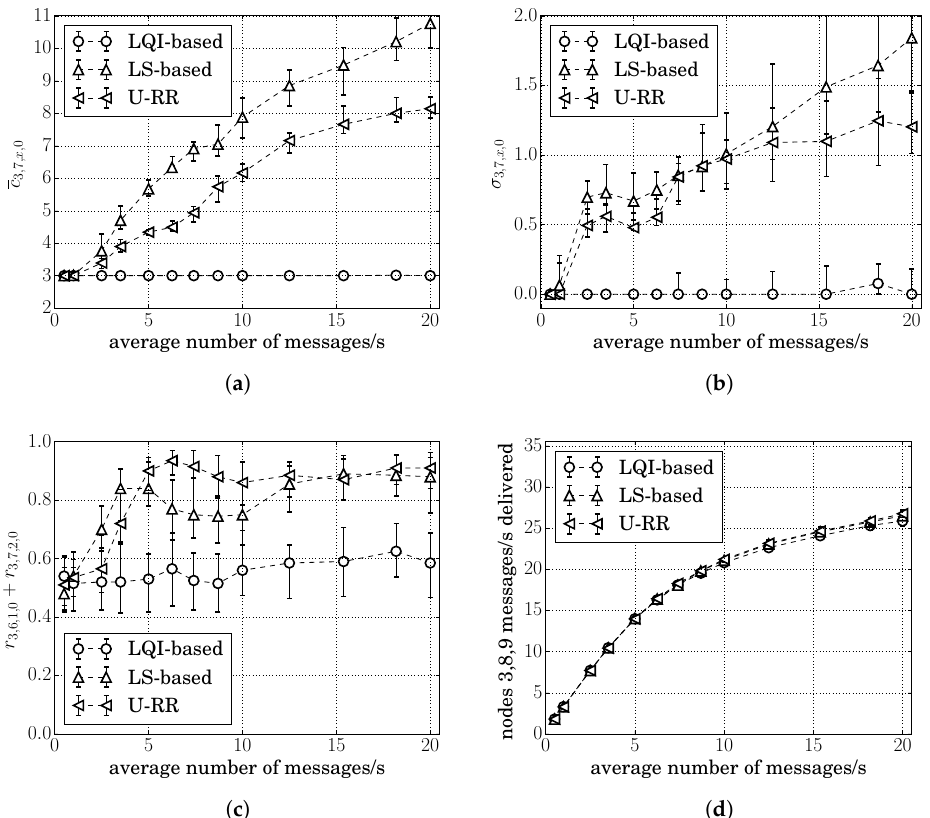
Figure 8. The median and the 15th to 85th percentiles of ( a ): the cumulative route cost of routes 3,7,x,0 ( c 3,7, x ,0 ), ( b ): the standard deviation of the estimated costs measured at node 3 for the routes 3,7,x,0 ( σ 3,7, x ,0 ), ( c ): the ratio of times that packets were relayed by the best routes 3,6,1,0 and 3,7,2,0 ( r 3,6,1,0 + r 3,7,2,0 ), and ( d ): the delivery rate of messages originated at nodes 3, 8, and 9 in the symmetric scenario